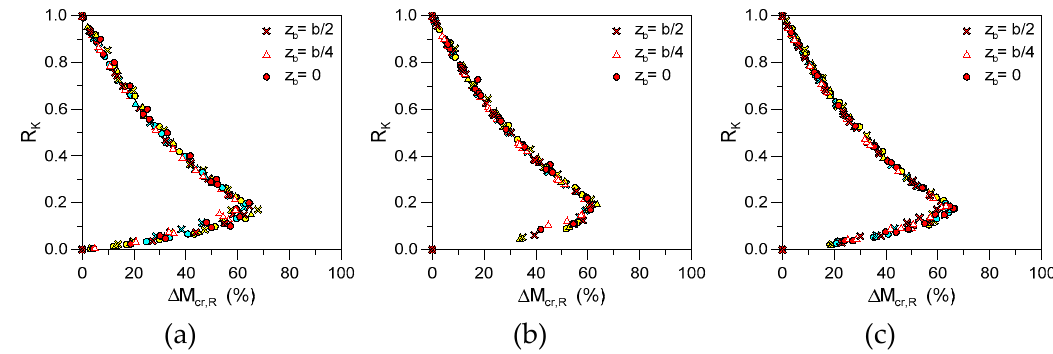
Figure 20. Percentage scatter (Equation (28)) for critical buckling moment estimates of selected LR glass beams ( n b = 2, K = var) grouped by span: ( a ) L = 2000 mm, ( b ) L = 3000 mm, and ( c ) L = 4000 mm (with t = 20, 30, 40 mm and b = 100, 200, 300 mm).